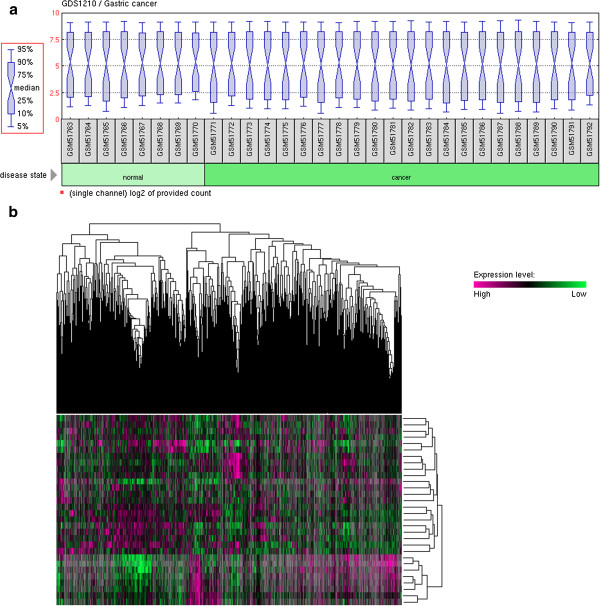
Boxplot for normalized gene expression data and cluster analysis results. (a) Boxplot of gene expression data. The medians are almost at the same level, indicating high normalization performance. (b) Cluster analysis results for gene expression data. The expression values clustered in the purple/magenta-shaded areas indicate overexpression, and the green-shaded areas indicate underexpression.